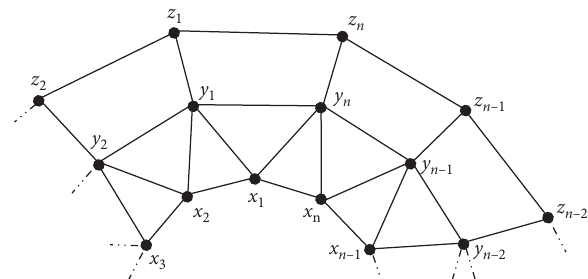
Figure 1: The n -dimensional convex polytope R